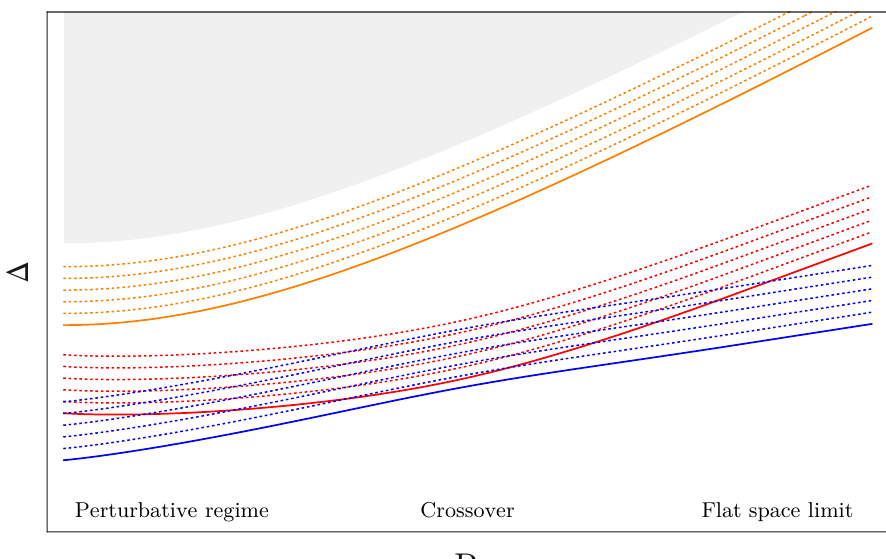
Figure 1. Sketch of the spectrum of the AdS Hamiltonian as a function of the AdS radius R . The solid lines describe different primary states, and for every primary we have drawn its five lowest descendants (dotted). Additional states at higher energies are not shown (shaded region). The slope of the lines on the right side of the plot measures the masses of different particles in flat